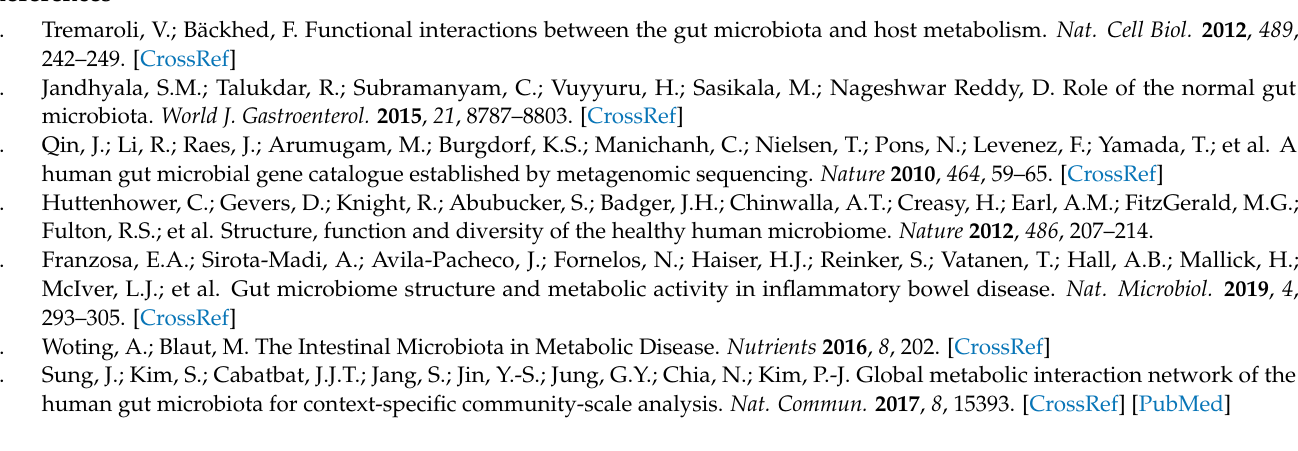
Table S2: Abundances of taxa at phylum level in vegans and omnivores, Table S3: Abundances of taxa at species level in vegans and omnivores, Table S4: Abundances of taxa at genus level in vegans and